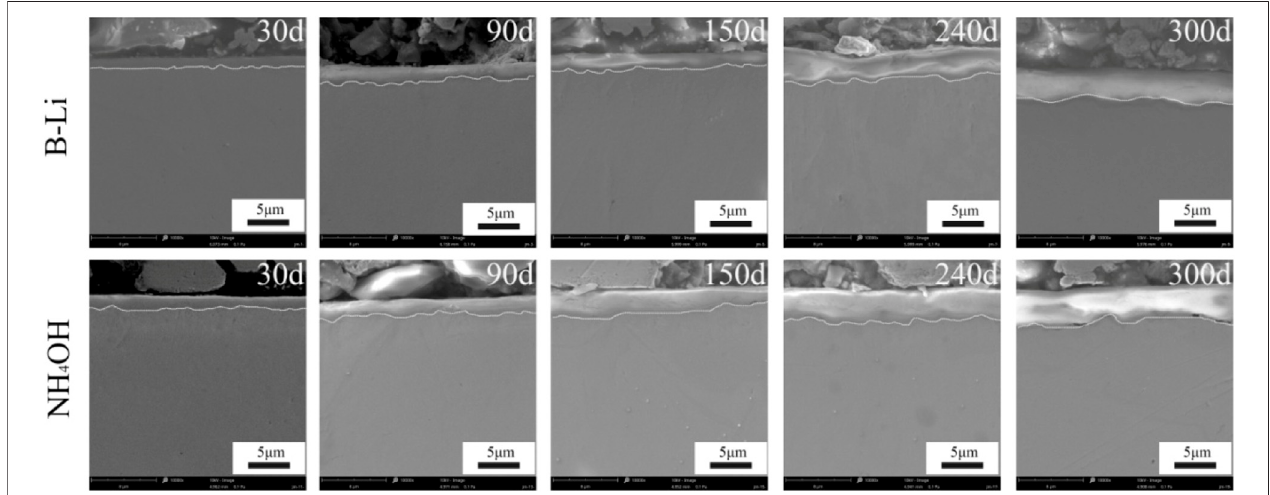
FIGURE 3 | SEM images of the cross-sectional morphologies of the oxidation fi lms.